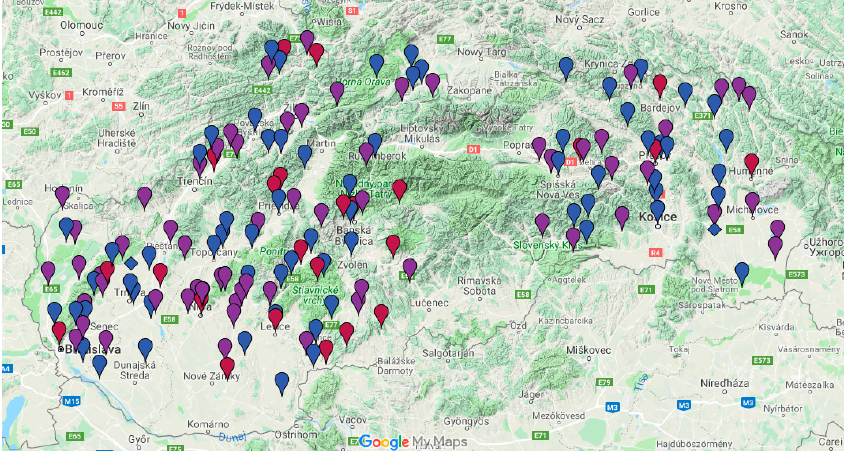
Figure 1. Pilgrimage sites in Slovakia (total of 159). (Note: Blue—Churches/Chapels, Red—Calvary, Purple—Cross Way. Source 1 ).